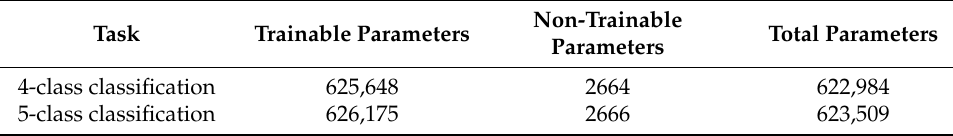
Table 2. Number of FirecovNet parameters in 4 and 5-class classification.